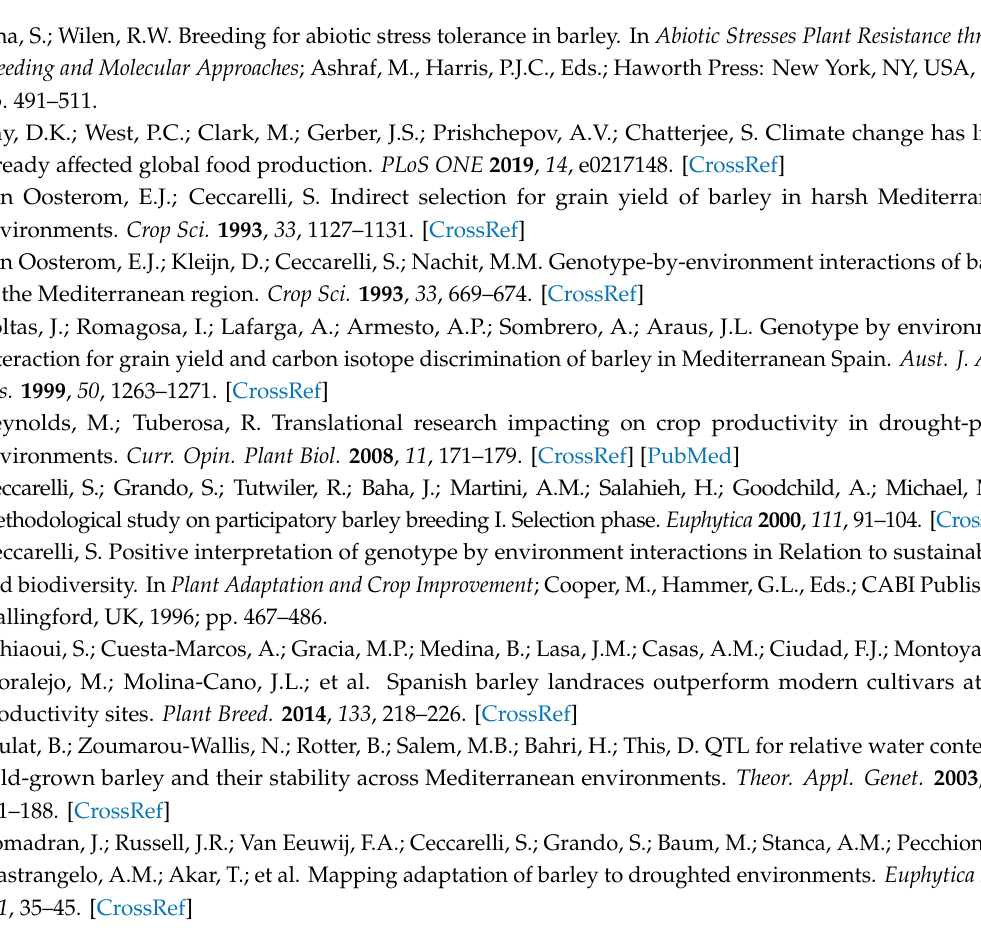
Table S1: Results of linear regressions of traits over time (in days), showing the coe ffi cients of determination of the regression lines of the traits (column R 2 time ) and of the di ff erences in regression parameters among the genotypes (column R 2 time + genotype ). Genotypic slopes in relation to the slope of genotype SBCC146, and significance of the di ff erences to SBCC146 are shown. Table S2: Hundred seed weight of the six barley genotypes. Figure S1: Photographs of plants grown in the experiment. Figure S2: Genotypic averages for all variables measured at the end of the experiment. Figure S3: Interaction graphs for selected traits with significant genotype × treatment and type × treatment